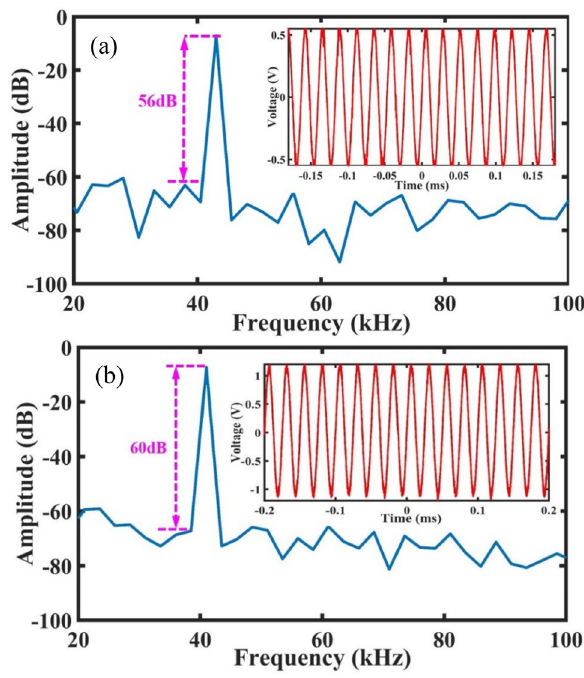
Figure 7. The time domain waveform and Fourier transformation of the EFPI sensor: ( a ) without FZP, and ( b ) with FZP.